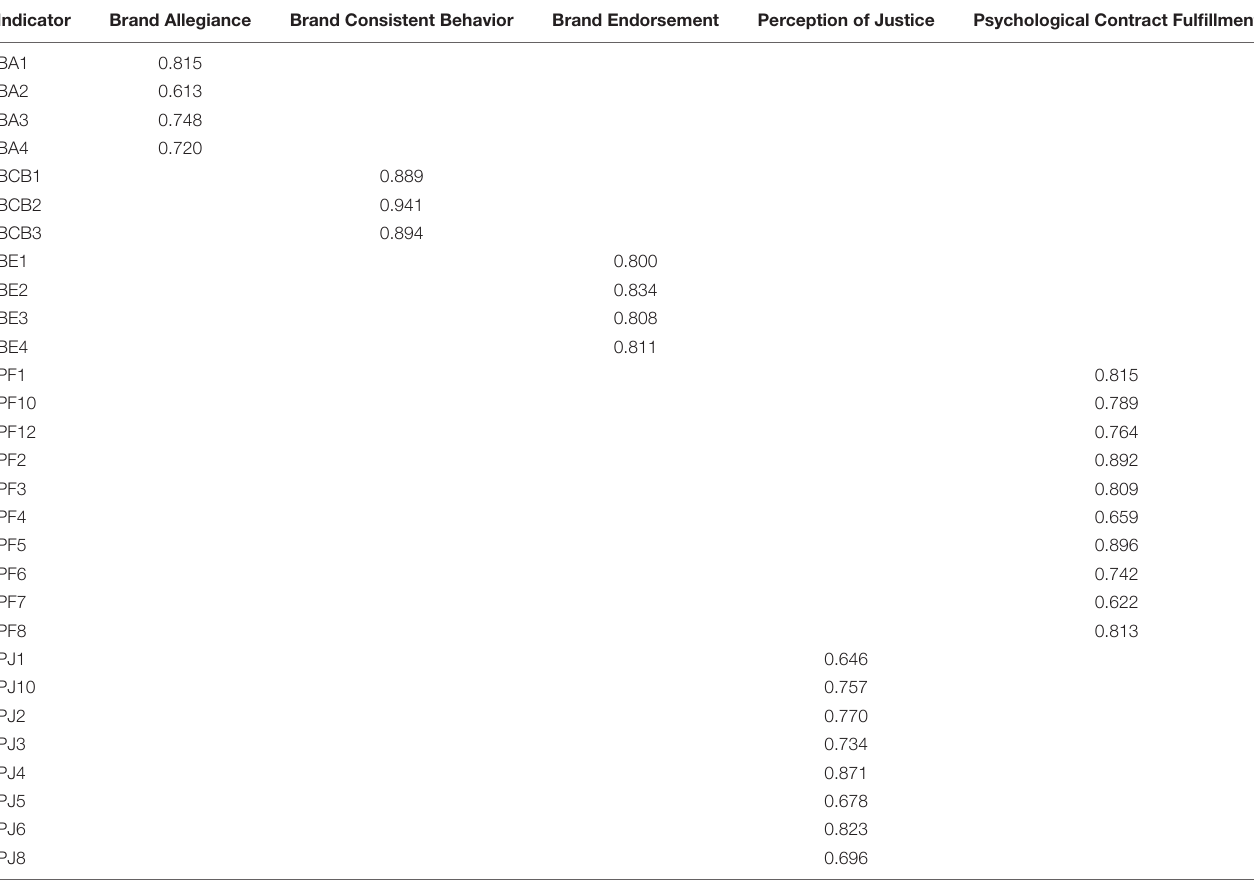
TABLE 1 | Outer loadings.